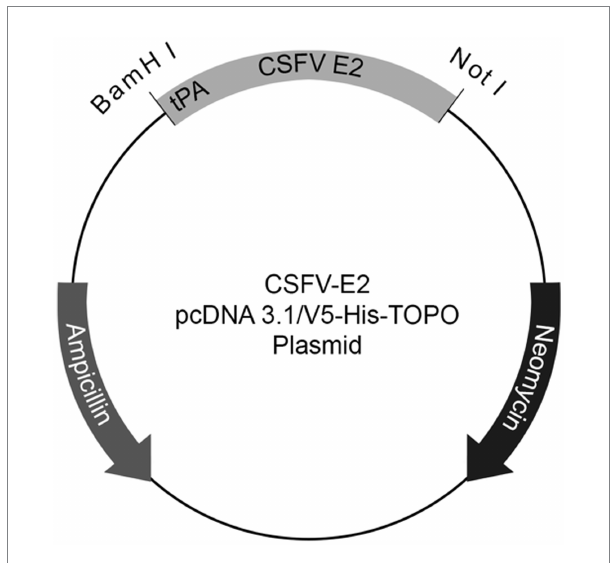
FIGURE 1 Schematic plasmid map of the recombinant CSFV E2 construct. Sequences of E2 modified by truncation of the transmembrane domains and addition of the human tissue plasminogen activator (tPA) sequence at 5 ′ -end with two restriction enzyme sites, NotI and BamHI, at 3 ′ and 5 ′ end of the sequences, respectively, were cloned onto the pcDNATM 3.1/V5-His TOPO ® TA mammalian expression